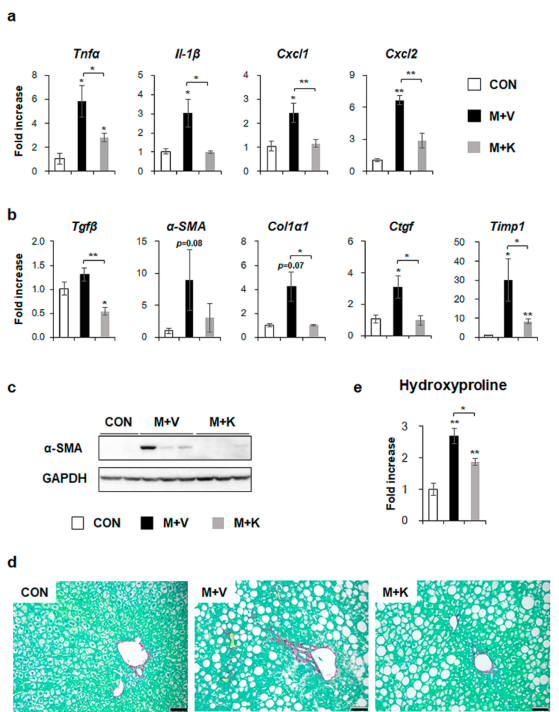
Figure 5. KT decreases both inflammation and fibrosis in livers of MCD-treated db / db mice ( a ) qRT-PCR analysis for tumor necrosis factor alpha (TNF α ), interleukin-1 β (Il-1 β ), chemokine (C-X-C motif) ligand 1 (Cxcl1), and Cxcl2 in livers from the CON, M + V, and M + K groups. ( b ) qRT-PCR analysis for transforming growth factor beta (Tgf β ), alpha-smooth muscle actin ( α -SMA), collagen type1 α